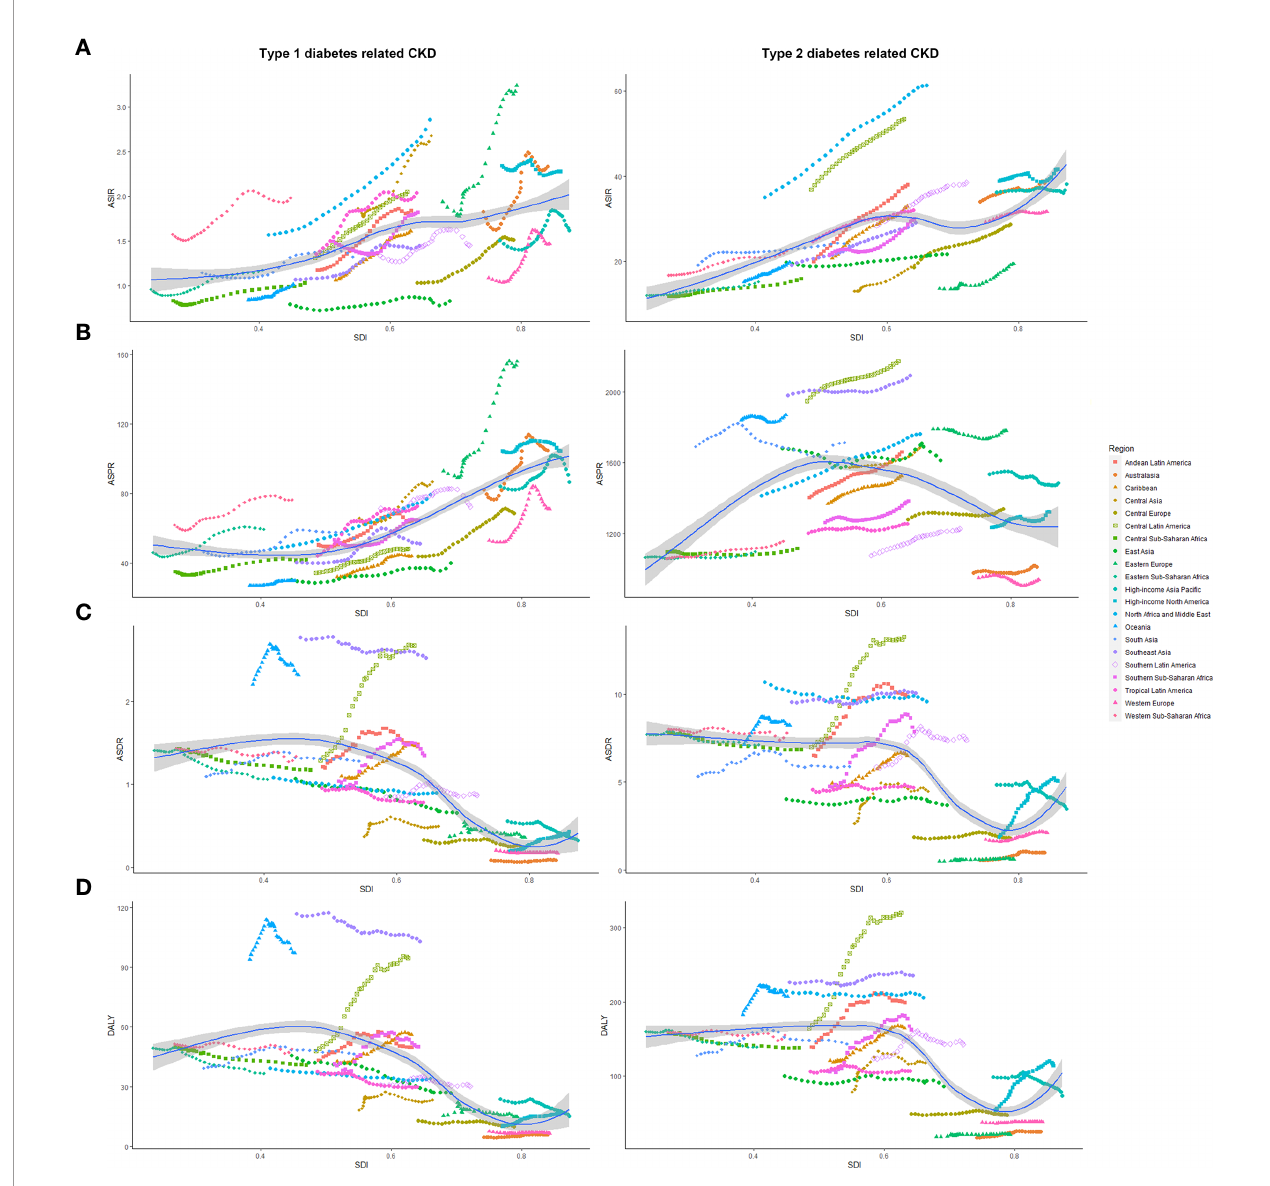
FIGURE 4 | The age-standardized rates of CKD-DM among 21 regions based on SDI in 2019. The vertical axis is the age-standardized incidence, prevalence, death, and DALY rate (per 100,000 person-years), and the horizontal axis is the SDI value in 2019. Each combination of colors and shapes represents a region, 21 in total. Each point represents the age-standardized incidence, prevalence, death, and DALY rate (per 100,000 person-years) that year in this region. Each combination of the same color and shape, from front to back, is the data for each year from 1990 to 2019. (A) ASIR (per 100,000 population); (B) ASDR (per 100,000 population); (C) ASPR (per 100,000 population); (D) Age-standardized DALY rate (per 100,000 population). ASIR, age-standardized incidence rate; ASPR, age- standardized prevalence rate; ASDR, age-standardized death rate; CKD-DM, diabetes-related chronic kidney disease; DALY, disability adjusted life-year; SDI, socio- demographic